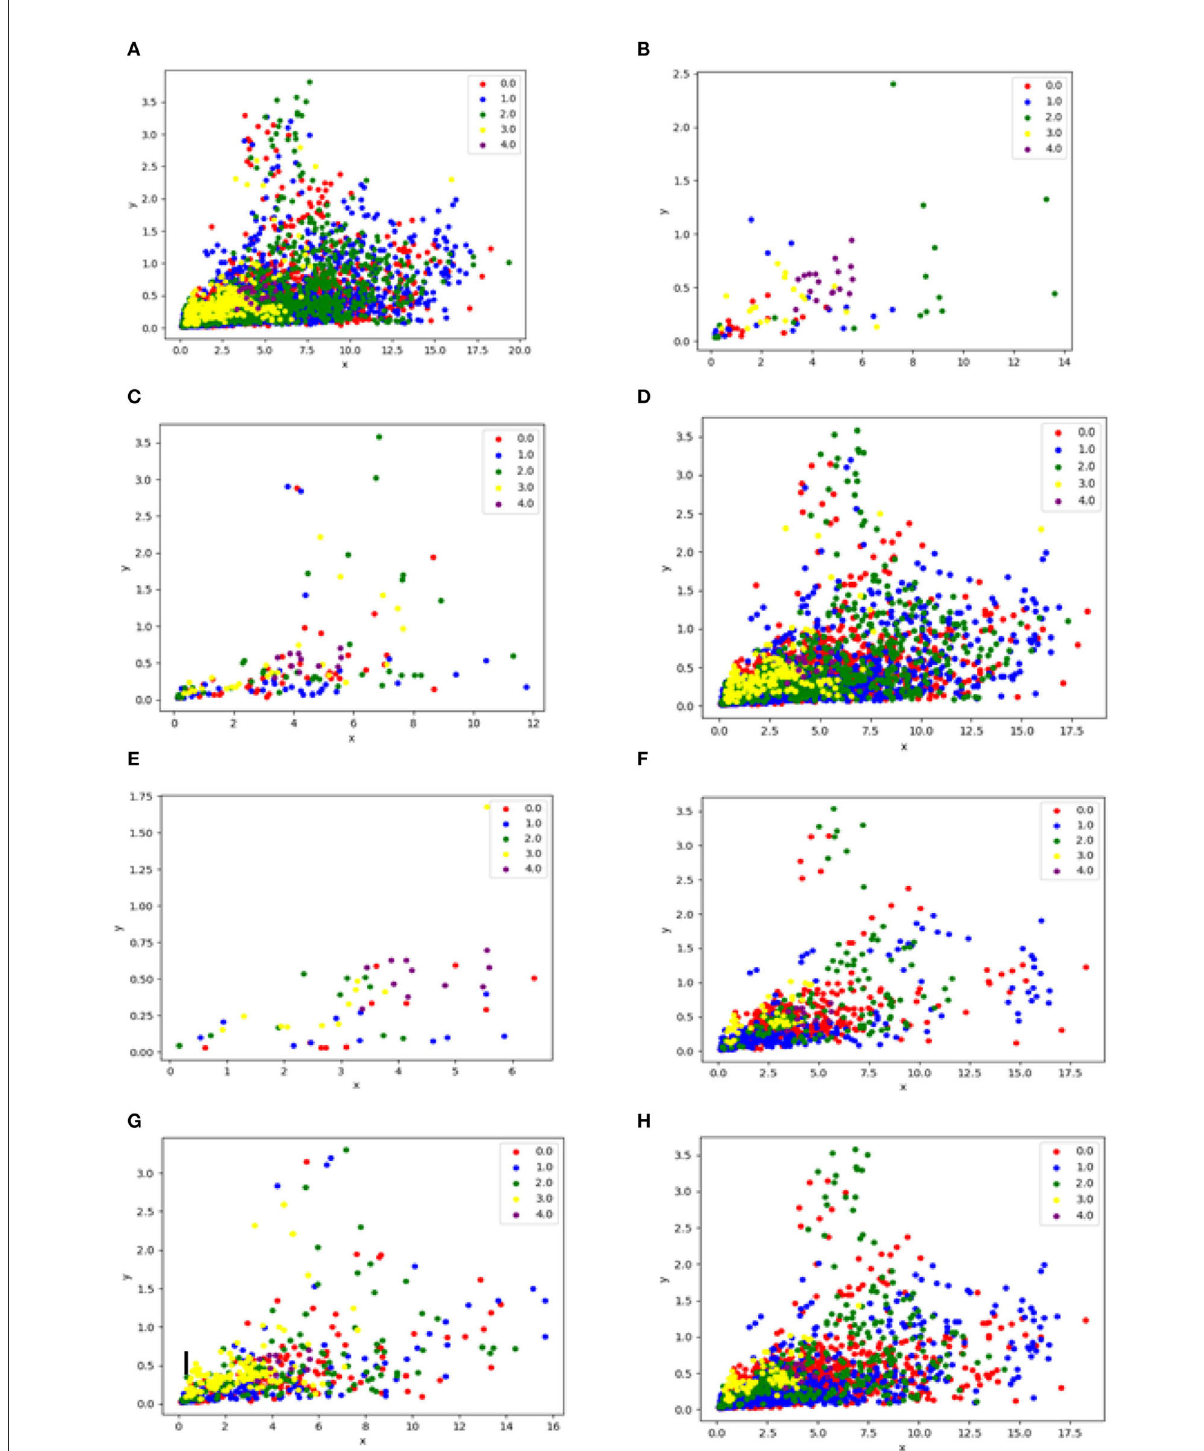
FIGURE2 This figure illustrates the difference before and after applying the under-sampling technique, (A) is data without resampling, (B) is data after applying the Random undersampling method, (C) is data after applying the CNN technique, (D) is data after applying the Tomek Links method, (E) is data after applying NearMiss method, (F) is data after applying the ENN resampling method, (G) is data after applying the OSS resampling method, (H) is the data after applying the NCR resampling